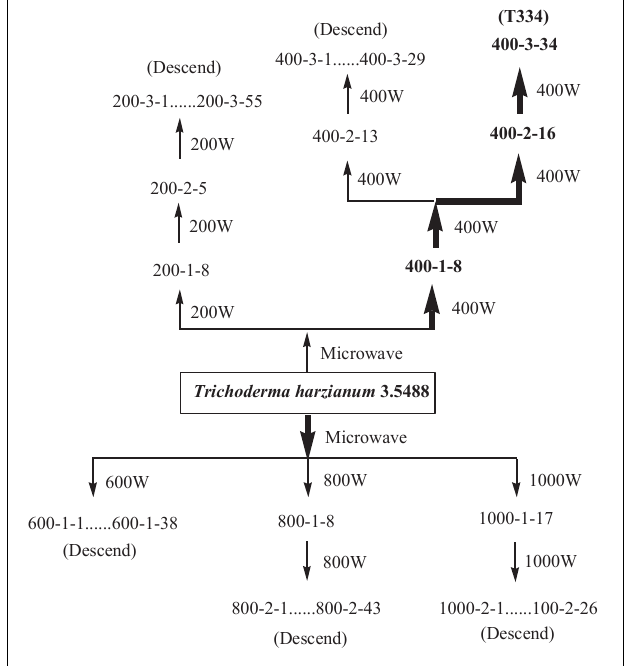
FIGURE 2 | Mutation spectrum of the T. harzianum mutant. The first group of numbers in the spectrogram indicates the microwave power, the subsequent numbers indicate the times of microwave irradiation, and then the number of the strain. For example, 200-2-5 represents the 5th mutant strain selected in the second round of mutagenesis under the condition of 200 W.